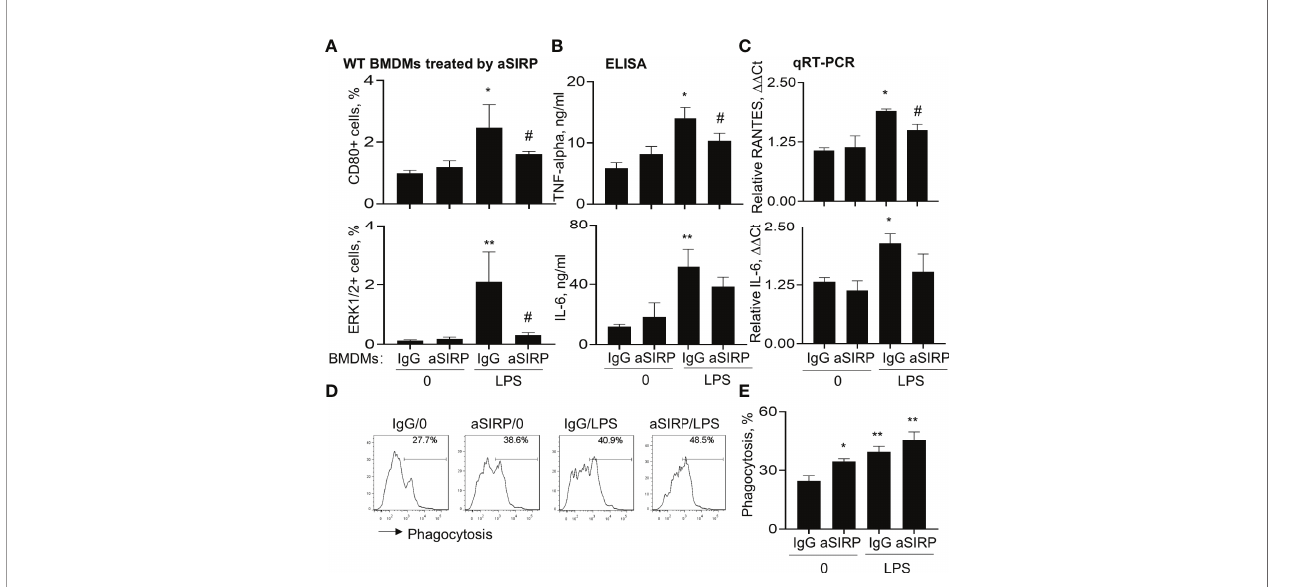
FIGURE 6 | Blockade of SIRP-alpha on macrophages by neutralizing antibody suppressed activation, expression of pro-in fl ammatory cytokines and improved macrophage phagocytosis. WT BMDM cells were pre-treated with 2 m g/ml anti-SIRP-alpha (aSIRP) or IgG isotype control for 1 hours and followed by stimulation with or without 500 ng/ml LPS for 24 hours. (A) Quantitative analysis of CD80+ and ERK1/2+ cells after fl ow cytometry. (B) ELISA analysis for the expression levels of TNF-alpha and IL-6 in the supernatants of treated cells. (C) mRNA transcripts of RANTES and IL-6 in the lysates of treated cells were measured by qRT-PCR. Data was presented as DD Ct. (D) Phagocytosis activity of the treated macrophage was measured by addition of PKH26-labeled apoptotic NPs at a ratio of 2:1 (apoptotic cells: macrophages) for 4 hours. Representative histogram. (E) Quantitative analysis of macrophage phagocytosis after treatment. All quantitative data was presented as mean ± standard deviation. *p < 0.05, **p < 0.01 vs. 0 group, # p < 0.05 vs. IgG group, n=3. One-way ANOVA followed by Tukey ’ s multiple comparisons